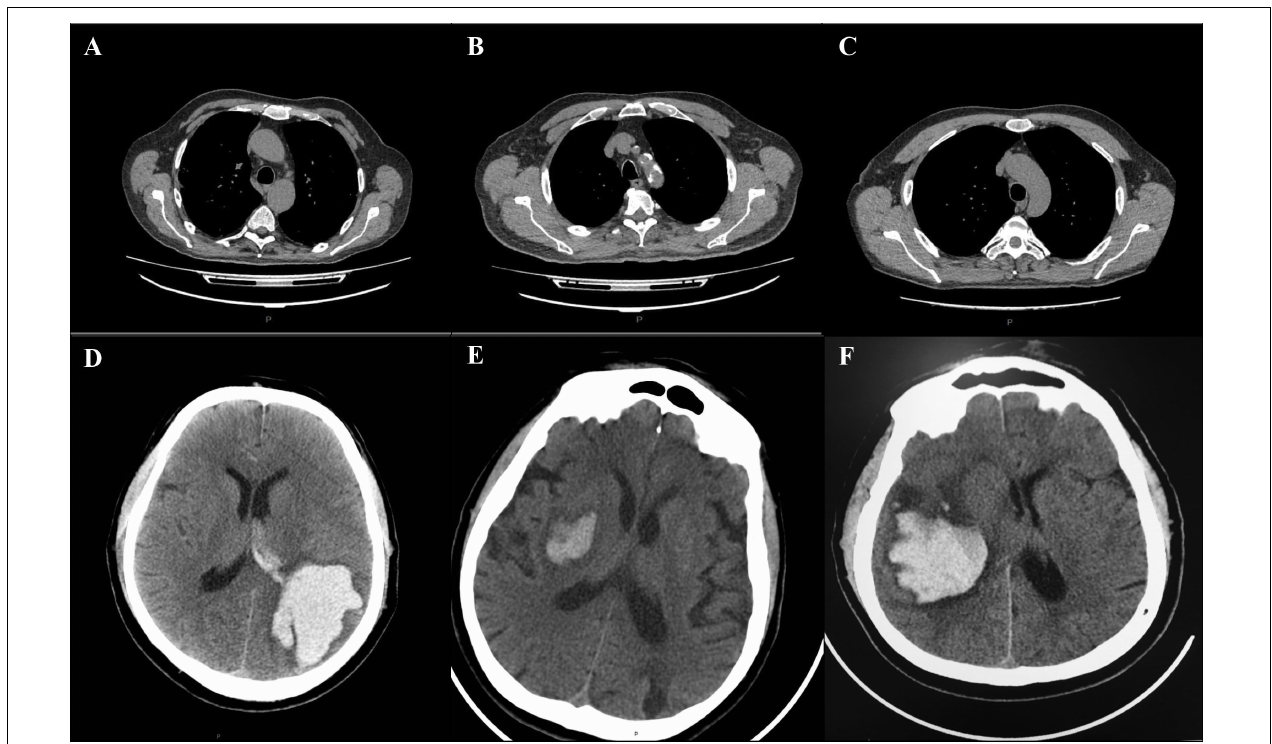
FIGURE 1 | CT changes of lung and brain in patients with COVID-19 complicated with ICH (A–F) . Chest and brain CT examination of patient 1 showing bilateral consolidations and ground-glass opacities of the lungs (A) , and hemorrhage in the parietal- occipital region on the left with a breakthrough of blood into the ventricular system (D) . Chest and brain CT examination of patient 2, showing diffuse bilateral ground-glass opacities involving both lungs (B) and hemorrhage in the projection of the basal ganglia on the right (E) . Chest and brain CT examination of patient 3, demonstrating bilateral ground-glass opacities (C) and hemorrhage in the projection of the basal ganglia on the right with a breakthrough into the ventricular system (F) . P =